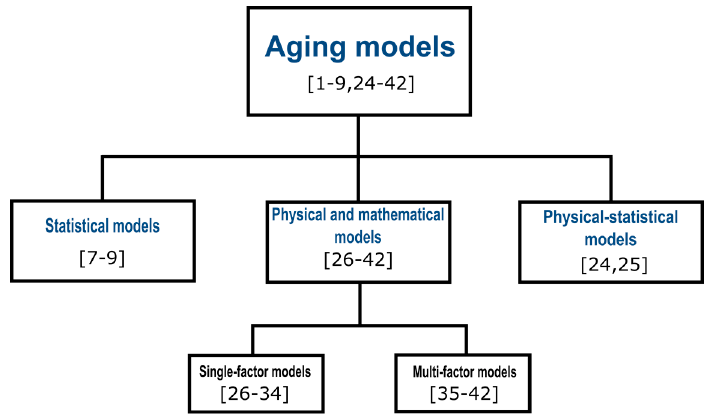
Figure 1. Different mathematical approaches to aging modeling [1–9,24–42].